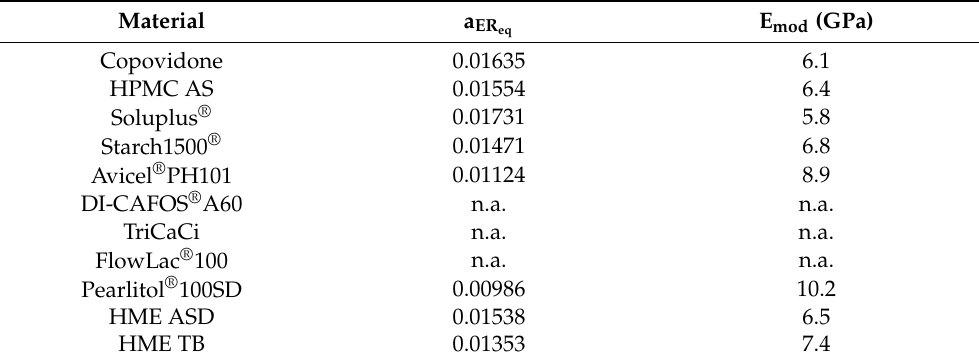
Figure 9. Heckel plots of polymeric excipients at 100 and 300 MPa calculated using particle density (  par ) or density under pressure (  pre ).